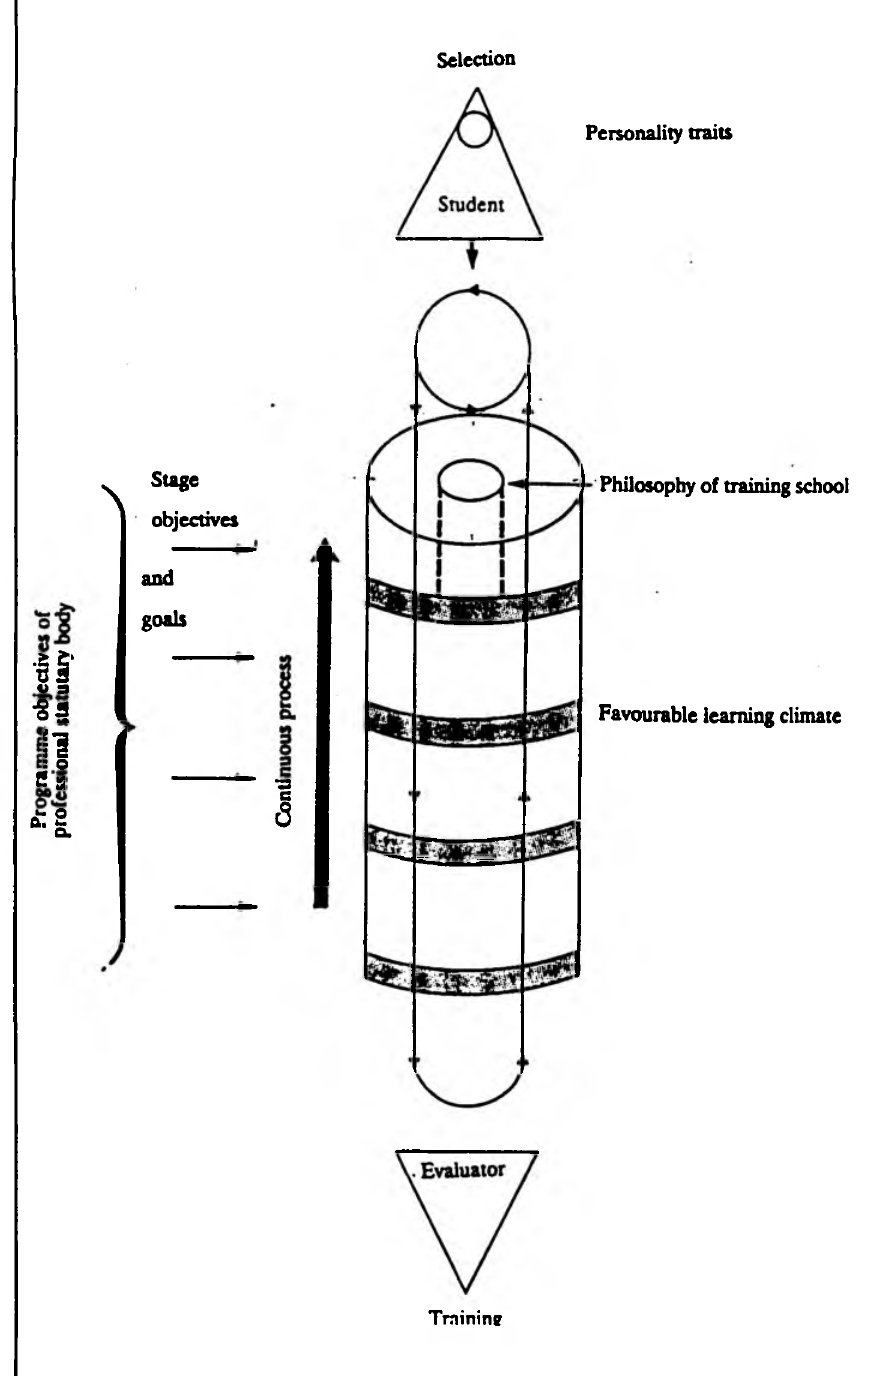
FIGURE 4: A DIAGRAMMATIC REPRESENTATION OF CLINICAL EVALUATION mare than the mere performance of individual skills or a specific effect It is, among others, the application of a scientific problem-solving process known as the nursing process, and the ability to function as a self-reliant, independent nurse